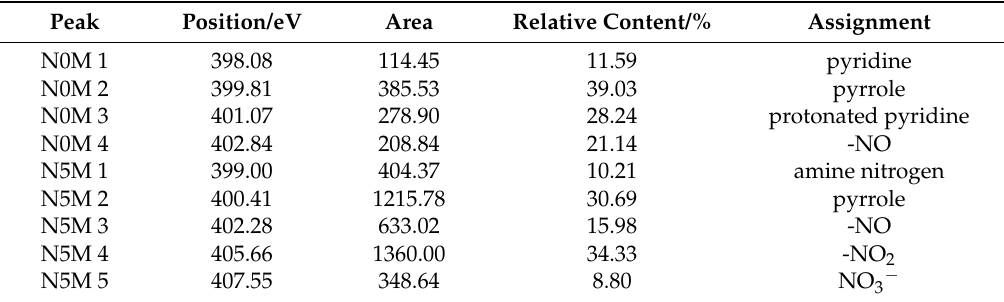
Table 6. XPS N1S peak synthesized data of lignite and nitric acid-modified lignite. Peak Peak Position/eV Area Relative Content/% Assignment